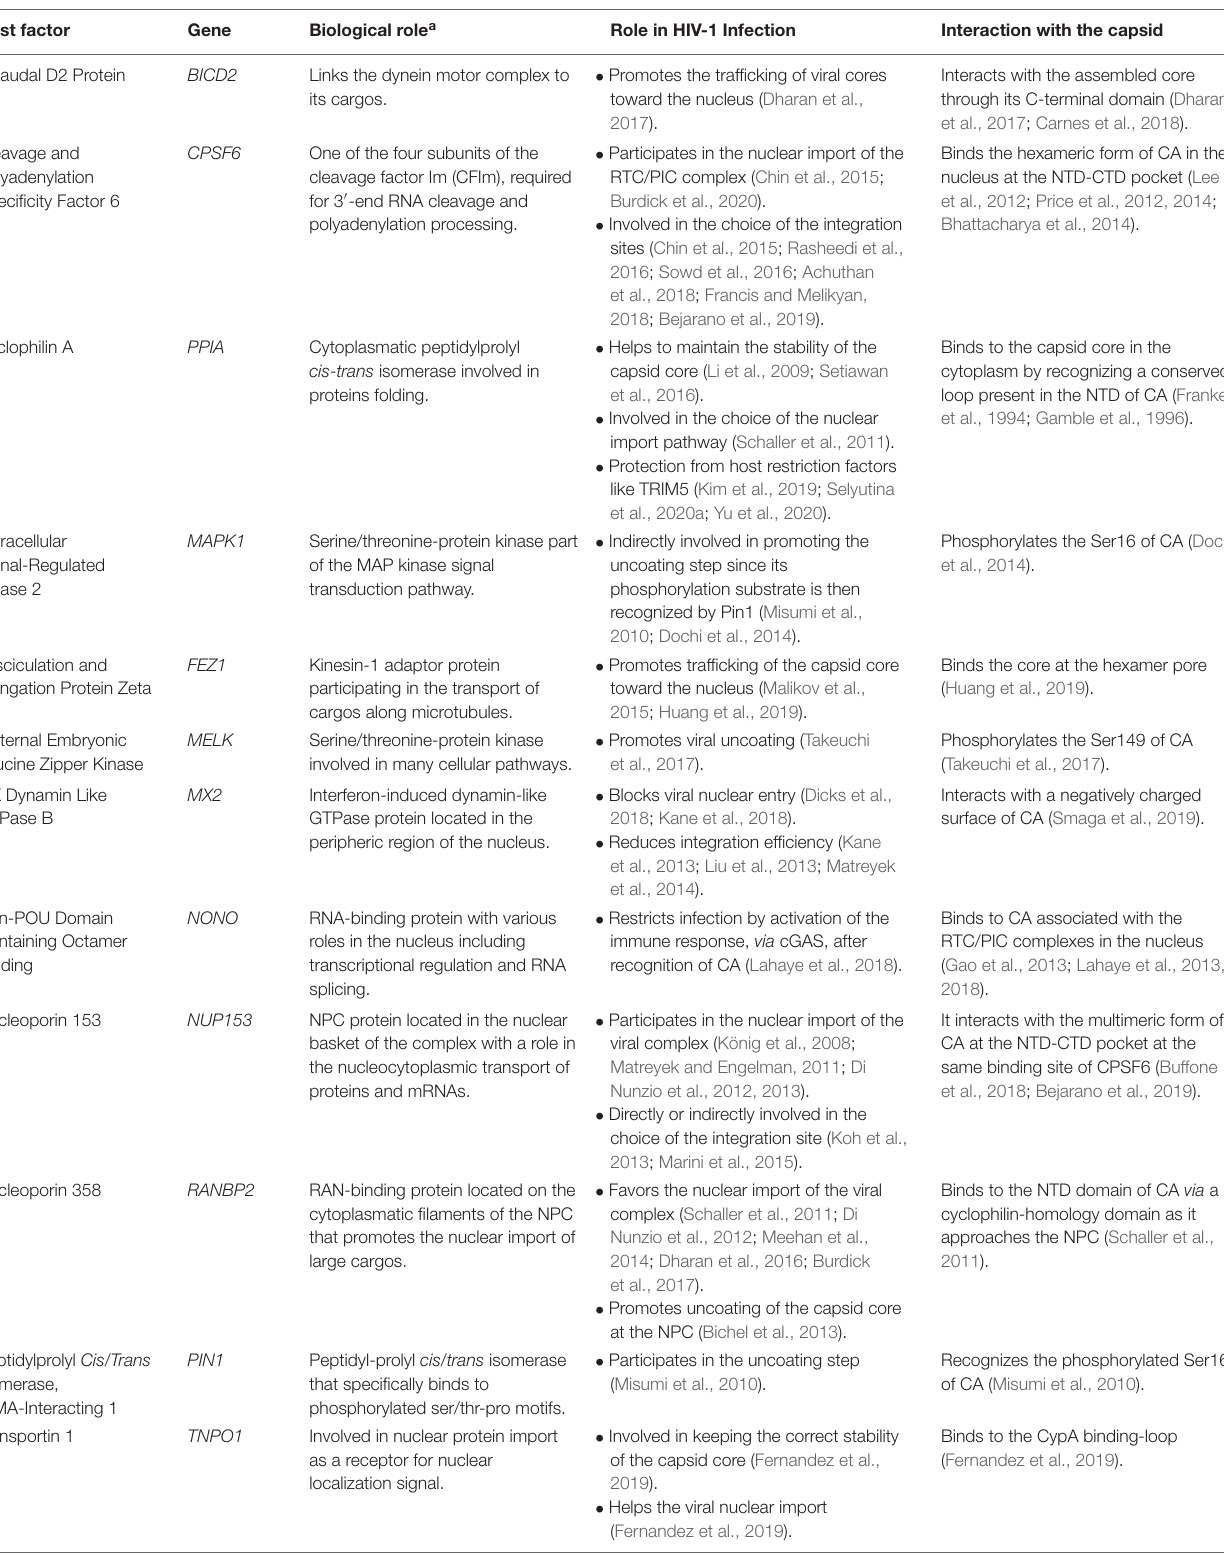
TABLE 1 | Host factors interacting with the viral